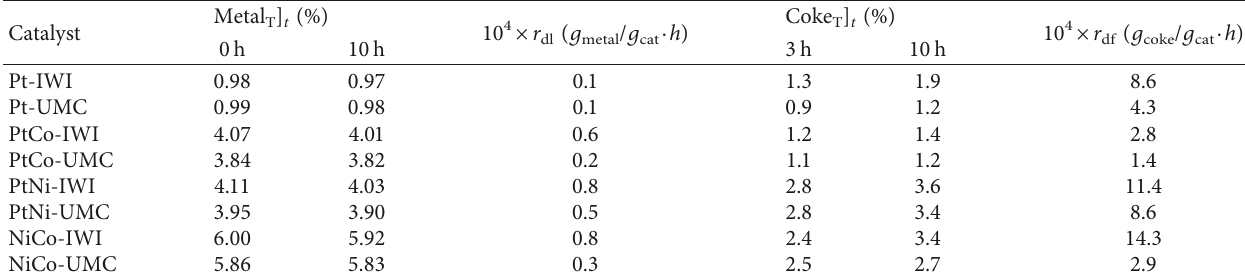
Table 3: Stability of the catalysts in APR of aqueous ethylene glycol (10%w). Catalyst